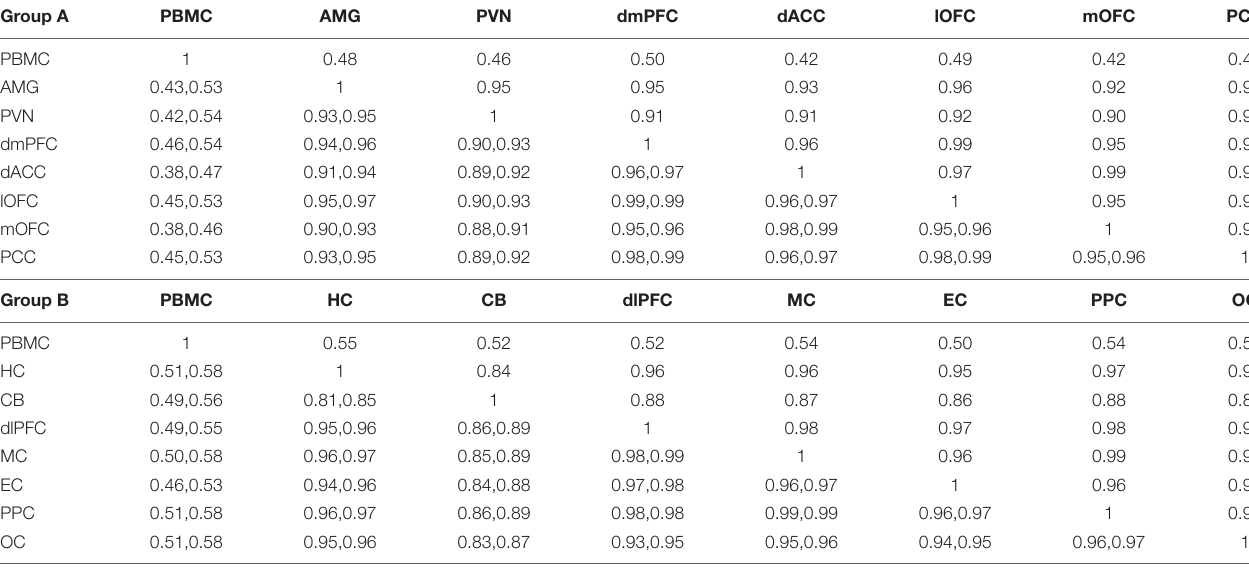
TABLE 3 | Pairwise Spearman’s correlations ( r s coefficients above diagonal) between blood and brain regions for mean expression counts for study samples per miRNA. Group